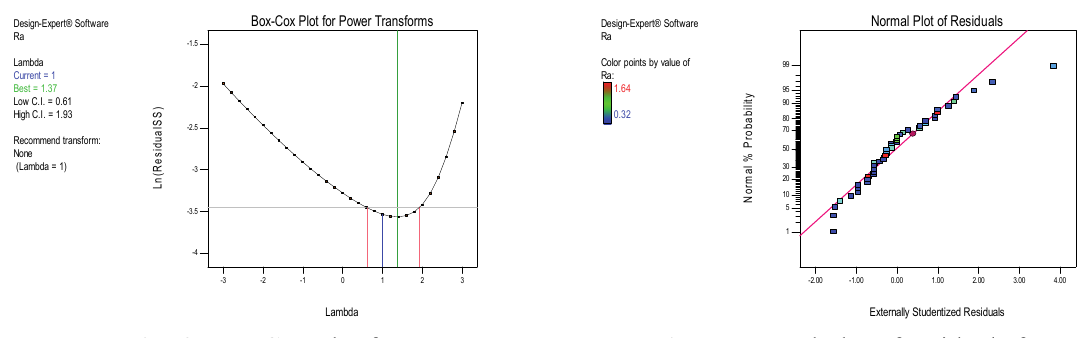
Fig. 4. Box-Cox plot for Ra Fig. 5. Normal plot of residuals for